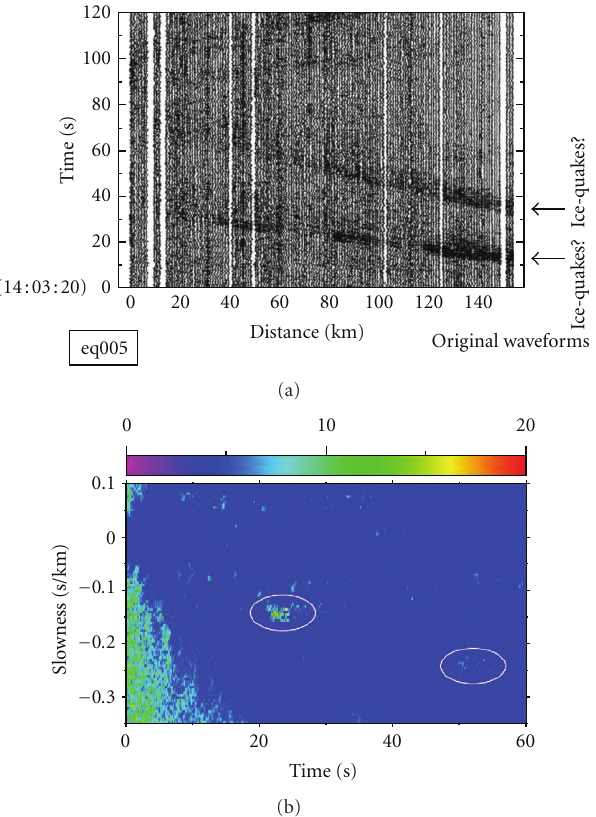
Figure 11: (upper) Recorded section for all the traces containing two large ice-quakes (event#; eq005; after [23]). Two identical signals can be clearly traced. The vertical axis starts from January 14, 2002, 14:03:20 (UTC). (lower) Contour map of PWS applied to these ice-quakes in the same time-window (modified after [23]). Peaks corresponding to two obvious events in the upper are indicated by white ellipses: peaks at (23s, − 0.135 s/km) and (51s, − 0.235 s/km). It is noted that high amplitudes found at the upper and lower left are artifacts caused by the PWS applied to zero- amplitude portions: since the zero amplitudes have the same value of phase components, a sum of the phase components should have a large